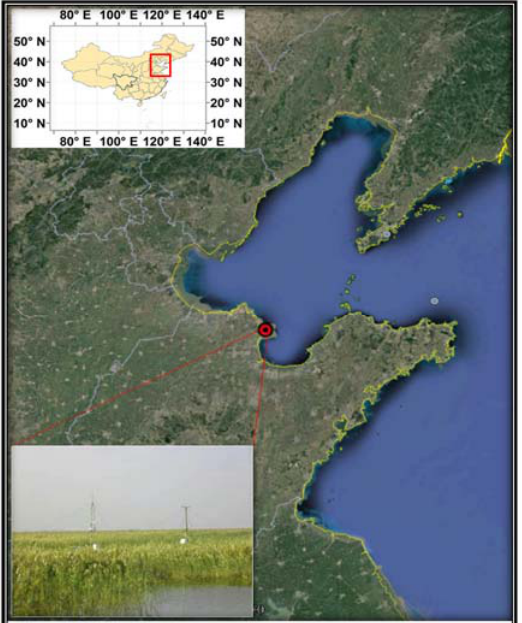
Figure 1. Study site location at the Yellow River Delta. The remote sensing data is derived from Google Earth. The eddy covariance system, including a flux tower and a weather station, was deployed at the coastal zone of Yellow River Delta Nature Reserve in 2008, with observation of CO 2 and water fluxes, air temperature, precipitation, photosynthetically active radiation (PAR), etc.